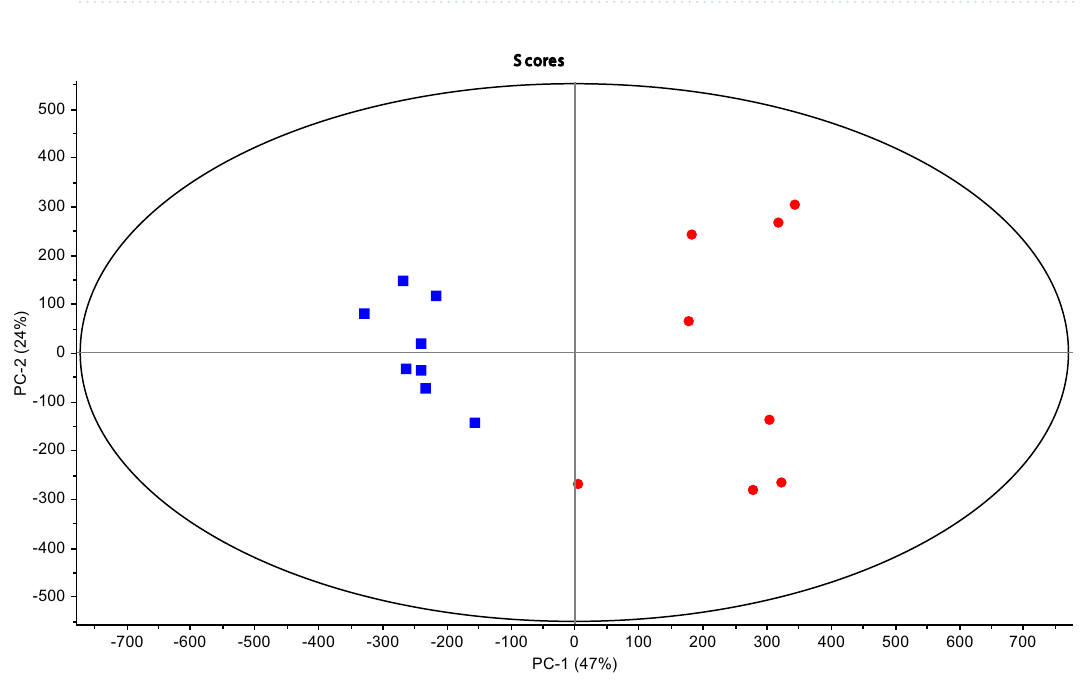
Figure 3. PCA Loadings plot for Mycoplasma fermentans from 1D 1 H NMR analysis of serum. REMSEC value for y variable = 0.244.